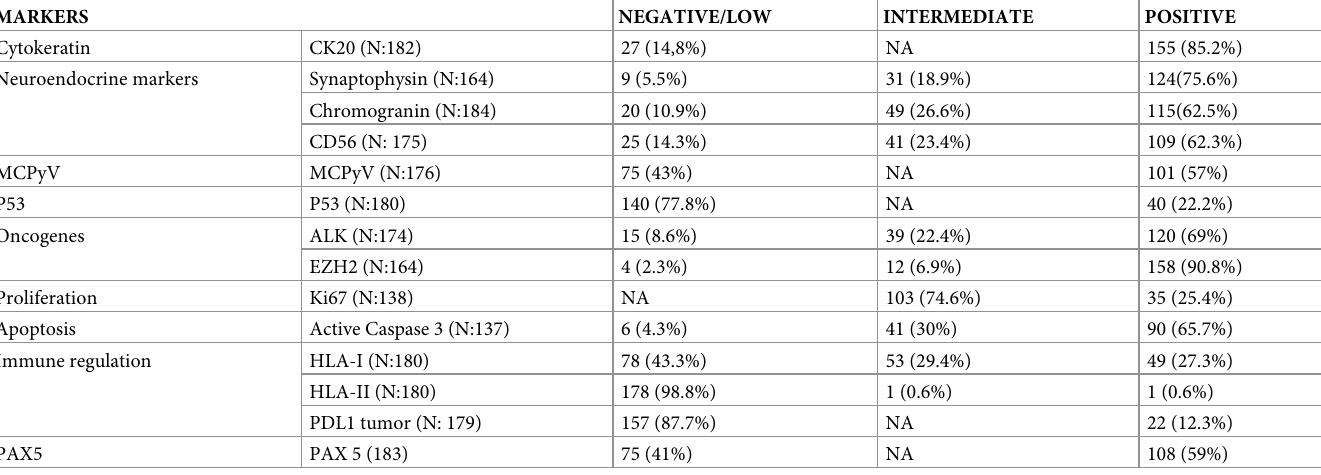
Table 4. Main IHC markers for the neoplastic cells.